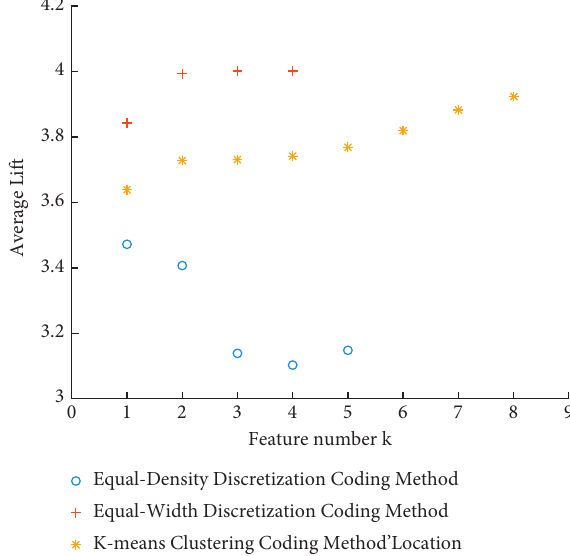
Figure 21: Average lift of different feature state coding methods. Table 11: Frequent feature pattern mining results based on the constant support threshold discriminant criterion. Frequent feature k -patterns